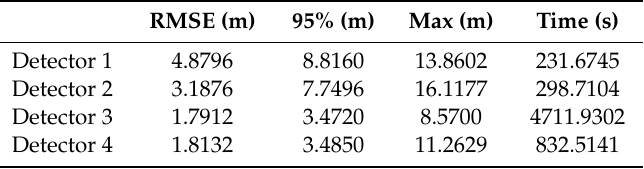
Figure 11. 3D positioning errors of the four detectors for the worst combination in Case 2: ( a ) detector 1, ( b ) detector 2, ( c ) detector 3 and ( d ) detector 4. Table 4. The numerical results of four detectors in Case 2.